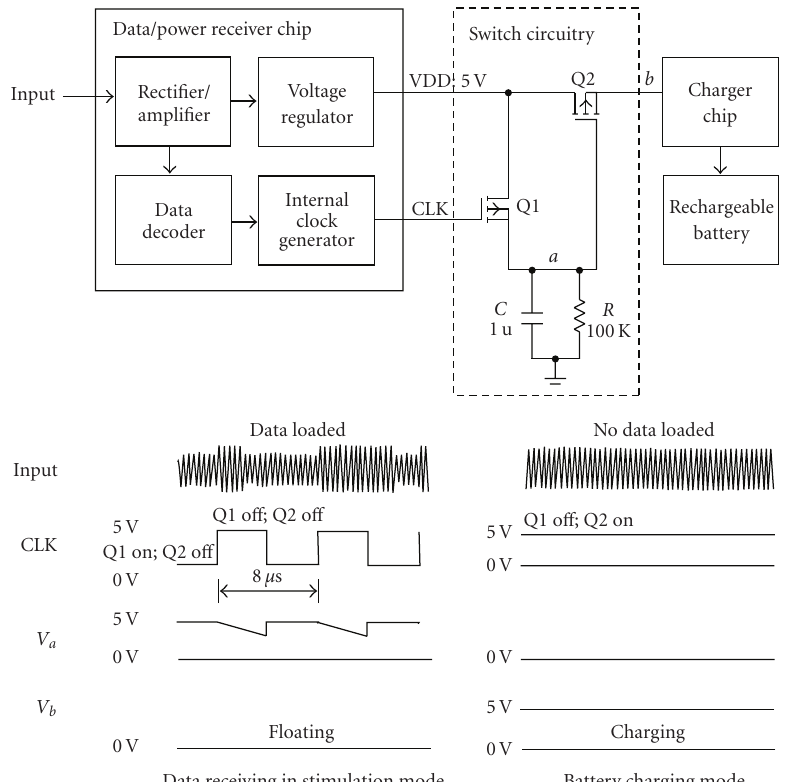
Figure 3: Operation of switch circuitry in stimulation and battery charging modes. When no data were loaded on 2.5 MHz carrier, CLK was logic high, therefore switch Q1 would be turned o ff , and the voltage of “a” node would be logic low, so switch Q2 would be turned on (battery recharging mode). If any data were loaded on 2.5MHz carrier, the CLK would recover and the voltage of node “a” never went below the threshold of switch Q2, so Q2 was turned o ff , this would be disabling the charger chip period (stimulation